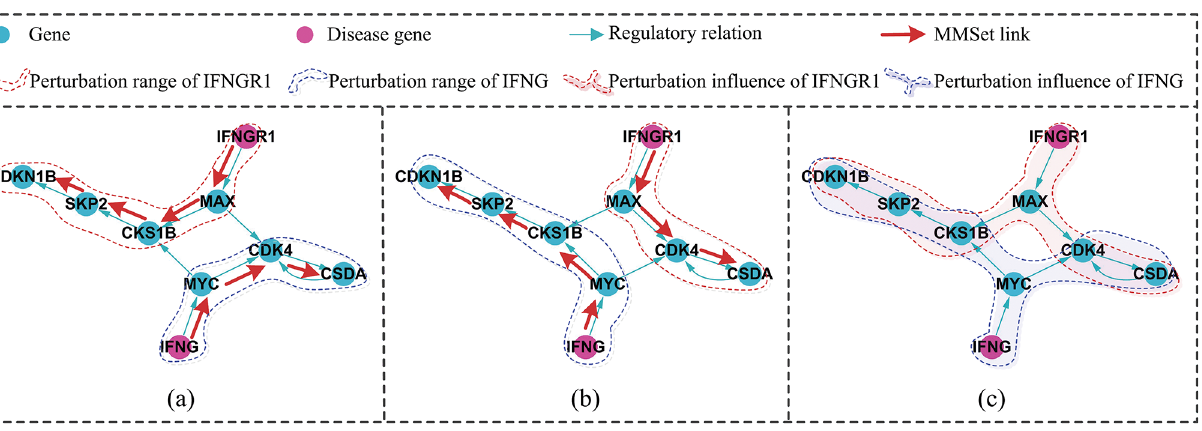
Fig 2. The perturbation influences of disease genes of the Tuberculosis (MIM:107470). (a): A CPSet of the partial human regulatory network, the MMSet links are highlighted by red, the disease gene IFNGR1 and IFNG are marked by purple, their perturbation ranges are circled with red and blue dotted lines respectively. (b): Another differentiated CPSet. (c): the perturbation influences of IFNGR1 and IFNG are marked by red and blue shadow respectively.